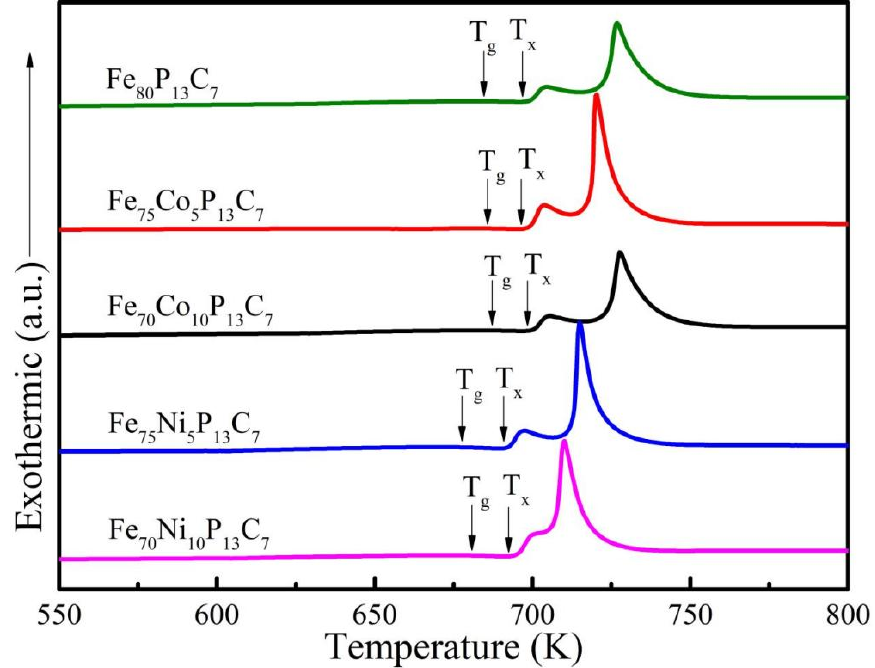
Figure 2. DSC curves of the as-cast Fe 80-x M x P 13 C 7 (M = Co, Ni; x = 0, 5 and 10 at.%) glassy alloy rods at a heating rate of 0.33 K/s.